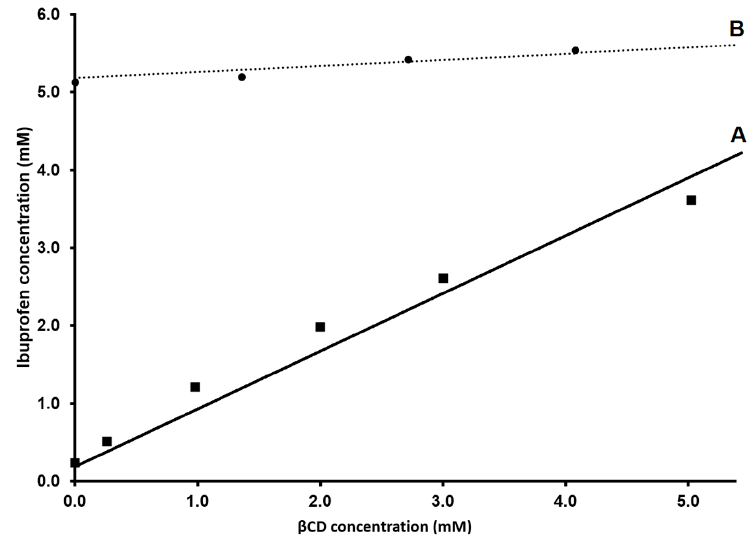
Figure 4. Phase-solubility profiles of IBU in the presence of β CD obtained at pH 3.8 ( A ) and at pH 7.4 ( B ). Personal communication data.